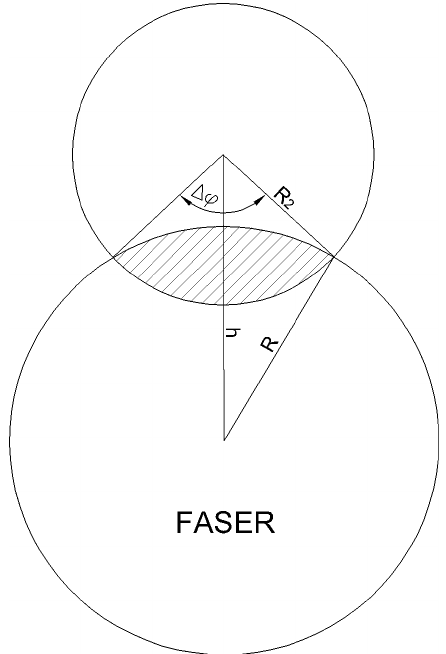
Figure 6 . Sgoldstino trajectory crossings (circle) the transverse to the beam line plane at the detector place (the encircled region denoted as FASER). The signal region is